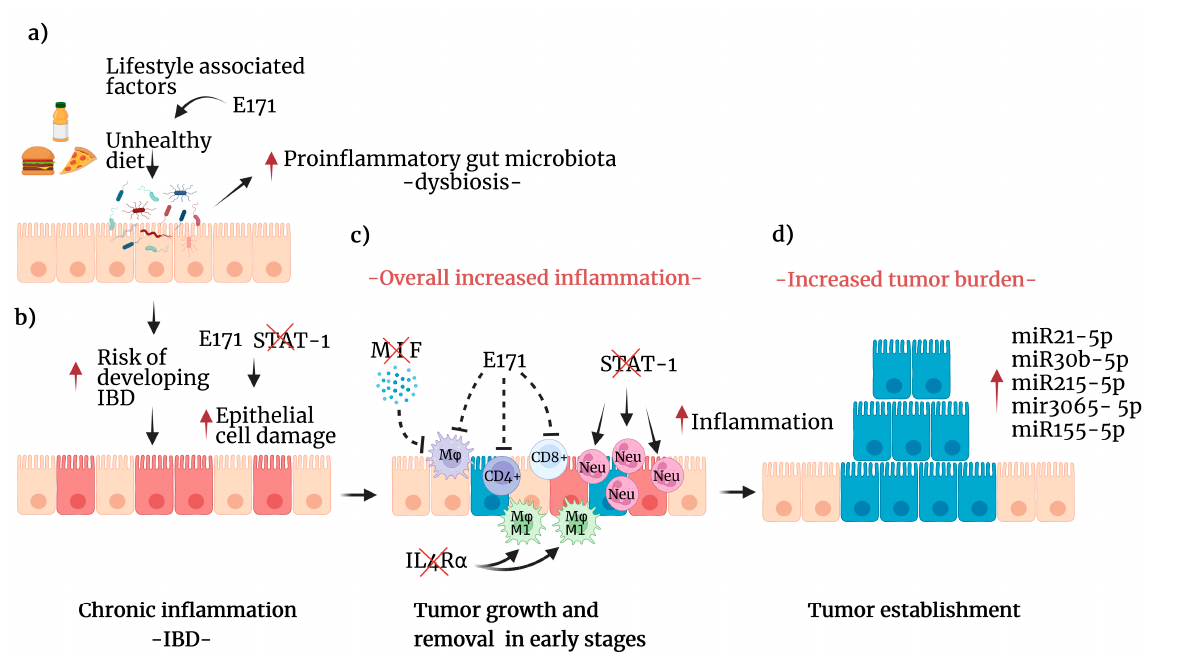
Figure 2. Lifestyle factors that increase the risk of developing CRC. ( a ) Effects of unhealthy diets include direct damage to epithelial cells, changes in the intestinal microbiota composition, and increases (red arrow) in proinflammatory bacteria leading to dysbiosis. These effects can be enhanced by food-grade titanium dioxide (E171). ( b ) Dysbiosis increases the potential of an IBD (red arrow), such as chronic colitis, in which chronic inflammation damages epithelial cells (red arrow). Additionally, E171 can affect the expression of genes associated with oxidative stress and DNA repair pathways. Furthermore, early STAT1 deficiency enhanced the damage and proliferation of colon cells. ( c ) The combined effect of this process attracts immune cells to detect and eliminate transformed cells (red). However, MIF deficiency reduces the number of macrophages recruited to the site, and E171 can impair the immune response. STAT1 deficiency leads to increased neutrophil infiltration, which exacerbates inflammation. Additionally, IL4R α deficiency leads to M1 macrophage polarization, enhancing inflammation (red arrow). ( d ) Cancer initiation and promotion mechanisms may include the reduced detection of transformed cells by the concert of immune alterations (in blue), leading to enhanced cell proliferation and tumor growth. Furthermore, in this stage, several miRNAs are differentially expressed (red arrow) and linked to tumorigenesis. Created with BioRender.com, accessed on 27 June